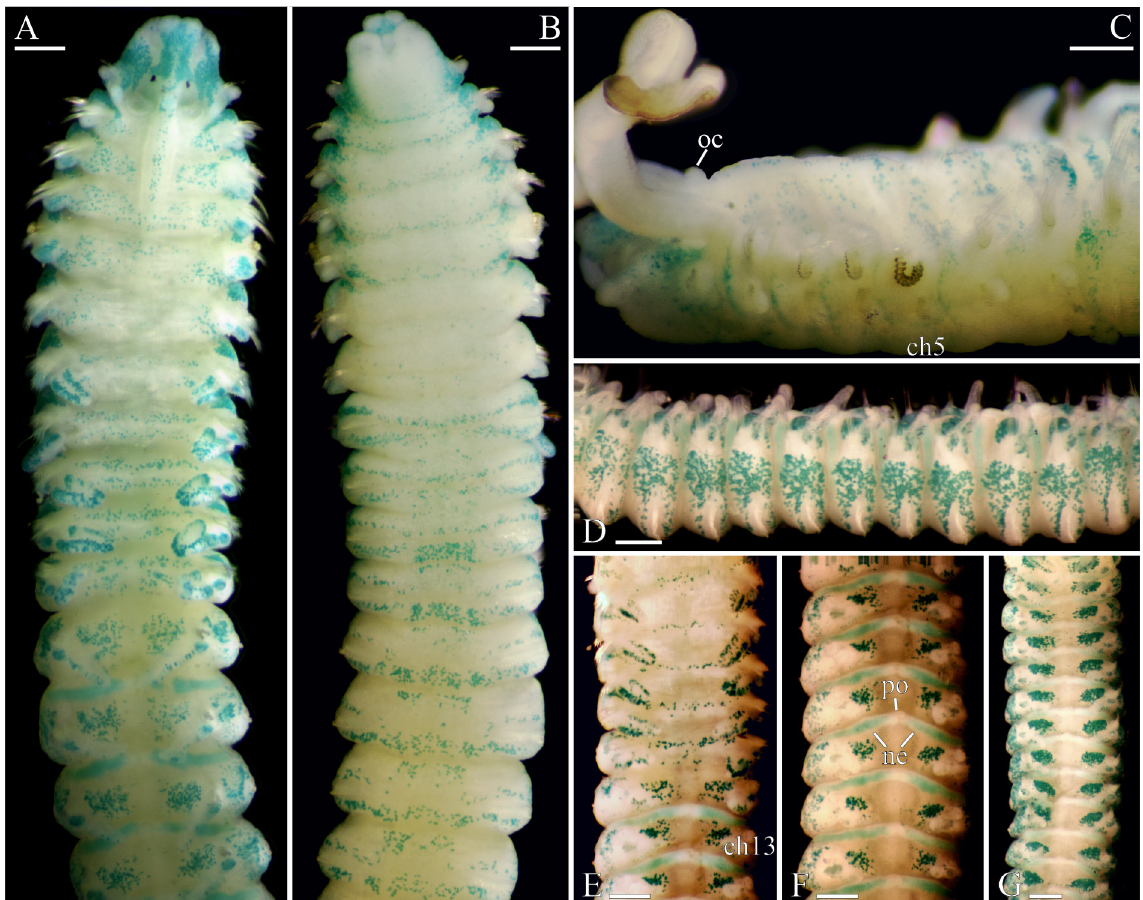
Fig. 18. Adult morphology of Pseudopolydora melanopalpa sp. nov. (formalin-fixed and stained with MG specimens, MIMB 40909). A–C . Anterior ends, dorsal (A), ventral (B), and left lateral (C) view. D . Middle chaetigers, left lateral view. E . Chaetigers 7–14, dorsal view. F–G . Middle chaetigers, dorsal view. Abbreviations: ch5 , ch13 = chaetigers 5 and 13; ne = nephridia in female fertile chaetigers; oc = occipital antenna; po = nephridiopore. Scale bars = 200